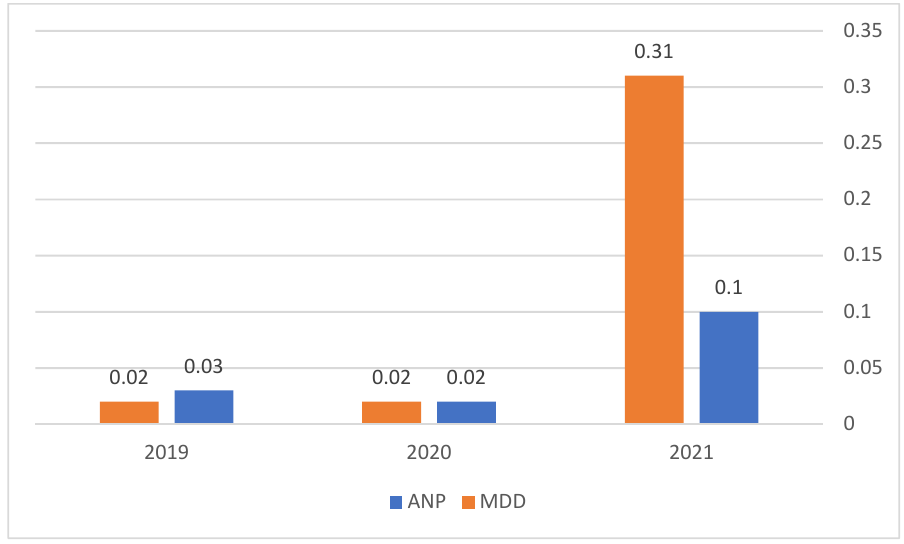
Figure 7. Cardano average NP and MDD per trade for 2019–2021. Note: ANP = average trade net profit, MDD = maximum loss per trade. The data for 2021 is until the end of September 2021.